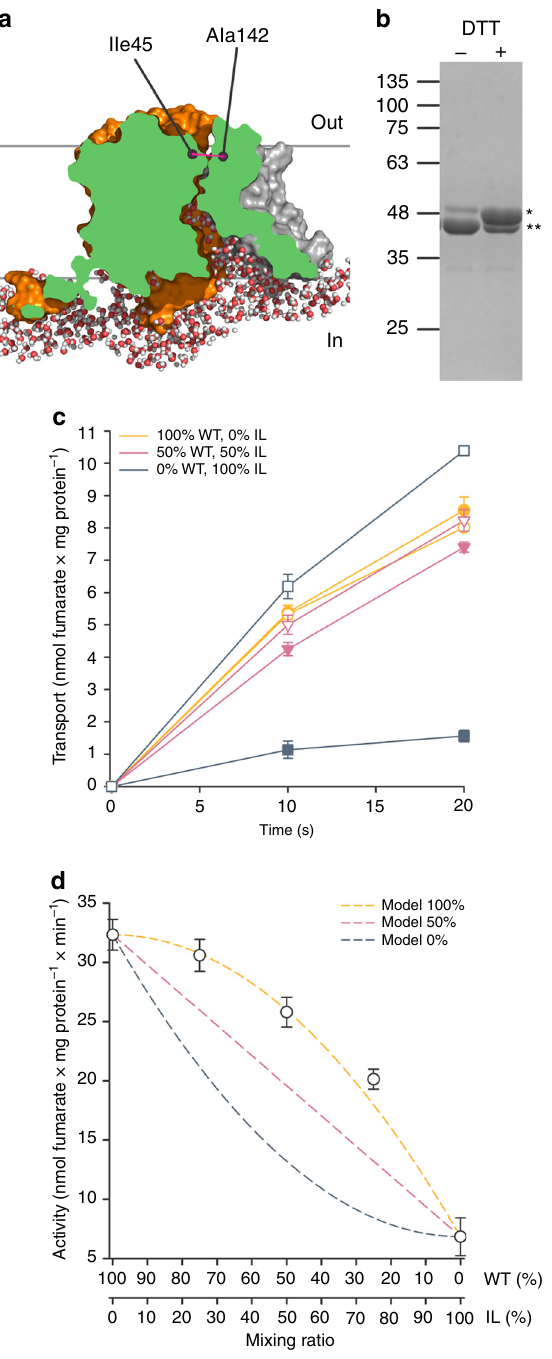
Fig. 5 Generation and functional characterization of SLC26Dg-IL. a Surface representation of MD-simulated SLC26Dg clipped through the funnel – toward the putative substrate-binding site. Cytoplasmic water molecules in a ~ 10 Å slab at the clipping plane are shown. Ile-45 and Ala-142 indicate the relative position of the cysteine mutants in the core (orange) and gate (gray) domain, respectively. b SDS-PAGE analysis of puri fi ed and cross- linked SLC26Dg-IL monomers in the absence and presence of DTT. Single and double stars indicate not-cross-linked and cross-linked protein, respectively. c Functional characterization of membrane-reconstituted and cross-linked SLC26Dg-IL (dark blue), wildtype SLC26Dg (orange), and both proteins mixed in equal ratio ’ s (pink). Closed and open symbols indicate the absence and presence of a pre-incubation step with DTT. d Initial transport rates of membrane-reconstituted and cross-linked samples containing wildtype and SLC26Dg-IL mixed in different ratio ’ s. Dark blue, pink, and orange dashed curves indicate the anticipated curves assuming an activity of the heterodimers corresponding to 0, 50, and 100% of the wildtype homodimers. These models were calculated assuming stochastic dimer formation (e.g., mixing WT:IL protomers in a 50:50 ratio results in 25% WT – WT, 50% WT – IL, and 25% IL – IL dimers) and speci fi c transport activities of 32.3 or 6.8 nmol fumarate per mg WT or IL homodimer per min, respectively, and heterodimer activities corresponding to 0, 50, or 100% of WT homodimer. Data points represent mean and standard deviations of three technical replicates. Source data are provided as a Source Data fi le